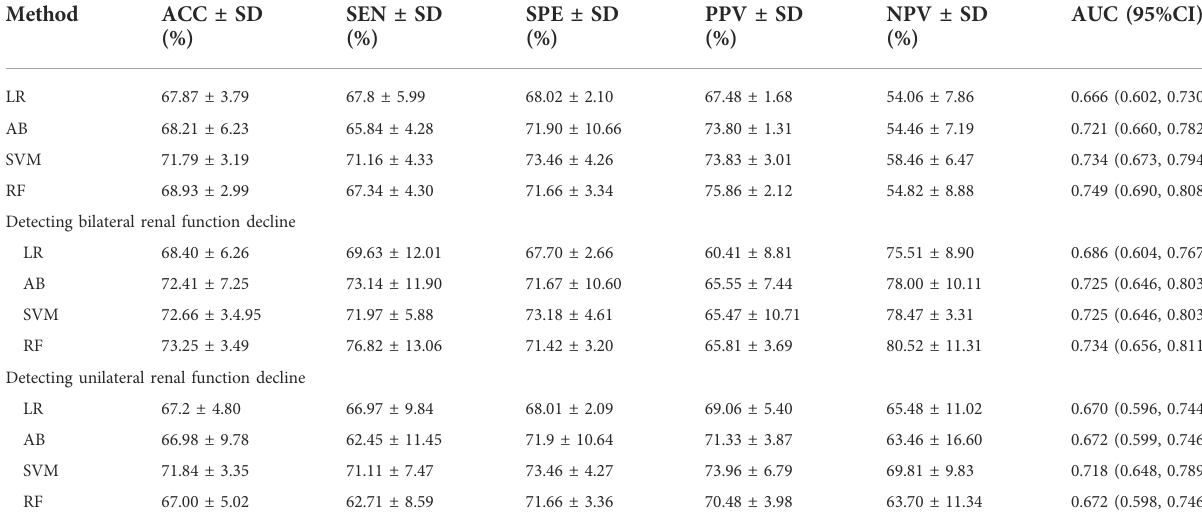
TABLE 3 Parameters of detecting renal function decline identi fi ed by DTPA or